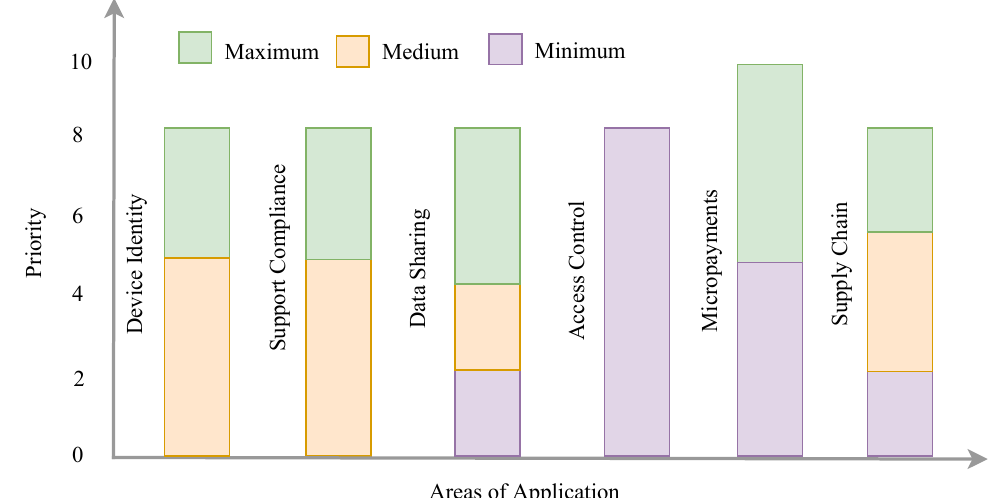
Figure 11. Application areas of six considered BC-based IoT use cases following assessments made by 10 operators with different